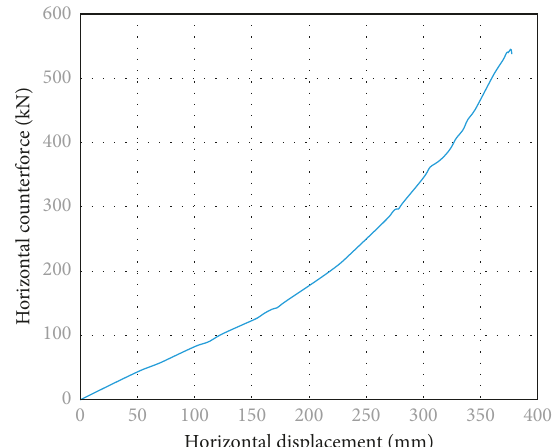
Figure 14: Relationship between horizontal reaction force and horizontal displacement of LNR500.